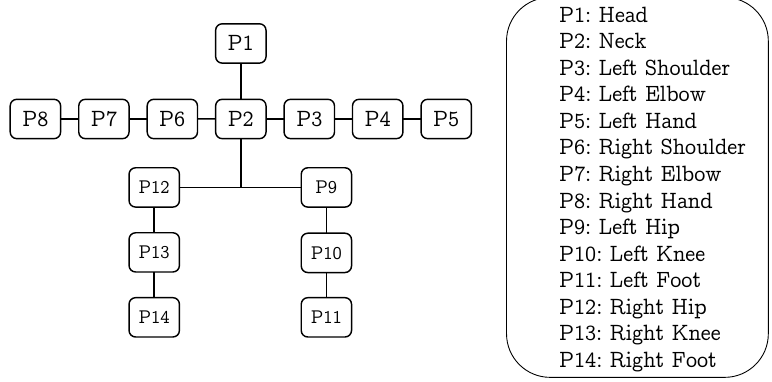
Figure 4. A kinematic tree of human body representing the relation between each body